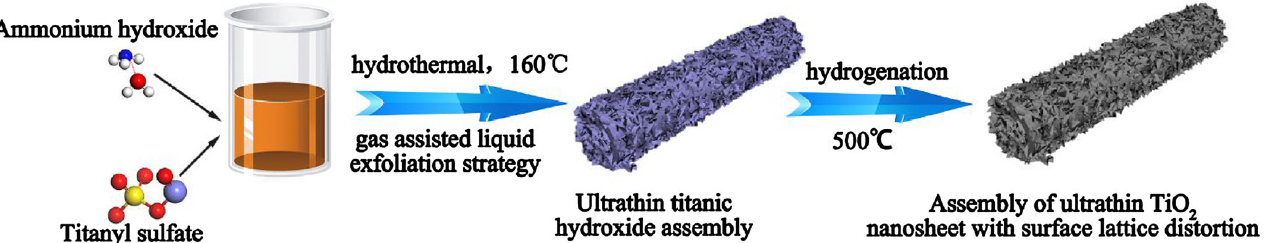
Figure 11. The schematic mechanism of assembly formation of titania ultrathin nanosheets. Copyright 2018 Elsevier [122].